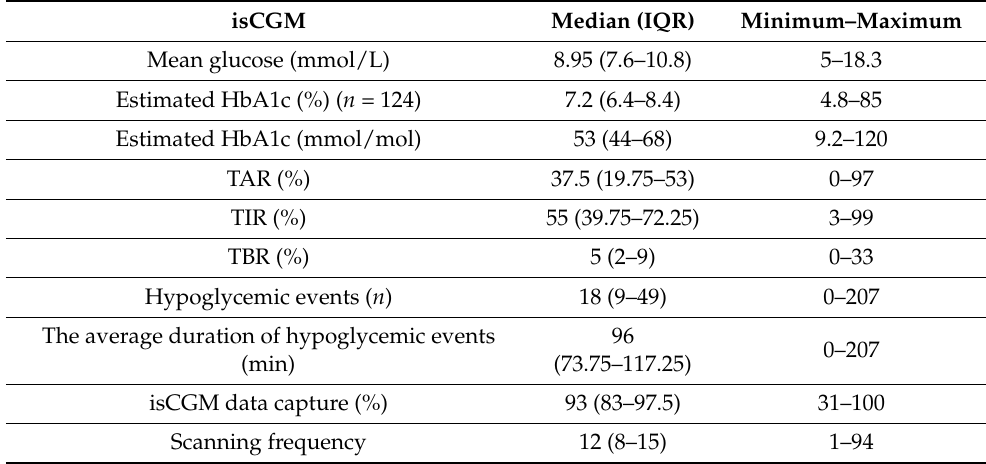
Table 4. Parameters of isCGM glycemic control after 3